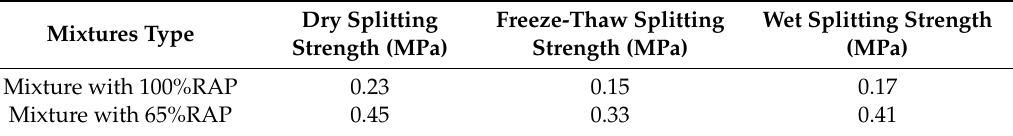
Figure 4. Comparison of Strength of Two Mixtures. Table 6. The dry, freeze-thaw and wet splitting